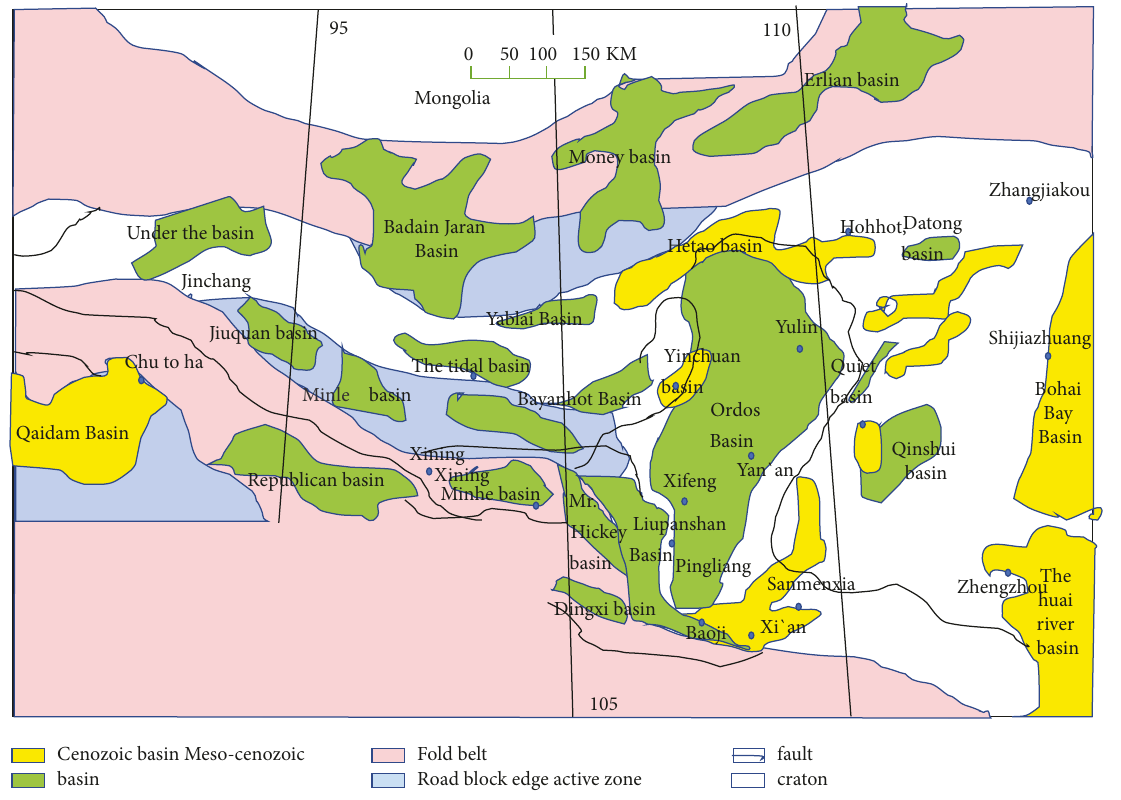
Figure 1: Distribution map of Ordos basin and its neighboring Mesozoic-Cenozoic basins.